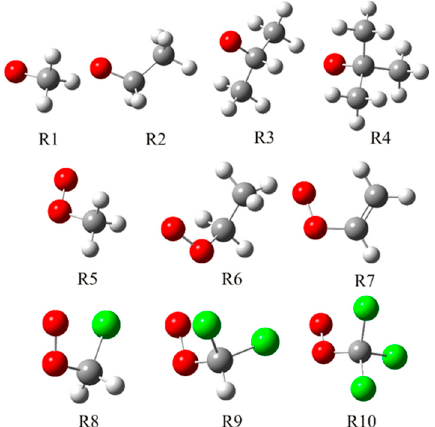
Figure 1. Optimised structures of the investigated free radical species: R1—methoxy radical, R2—ethoxy radical, R3—isopropyloxy radical, R4— t –butoxy radical, R5—methyl–peroxy radical, R6—ethyl–peroxy radical, R7—vinyl–peroxy radical, R8—chloromethyl–peroxy radical, R9—dichloromethyl–peroxy radical, and R10—trichloromethyl–peroxy